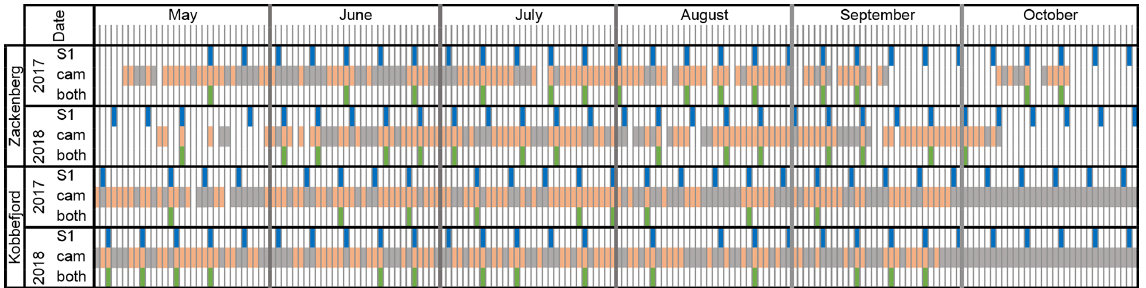
Figure 3. Acquisition dates of available data: blue – Sentinel-1 (S-1); grey – camera time-lapse imagery excluded due to bad quality; orange – used camera images; green – coinciding S-1 and camera dates, which were used for comparison and assessment of the products. The developed approach also uses S-1 acquisitions before May and after October, but the acquisitions are not shown here for better visualization of the relevant observation